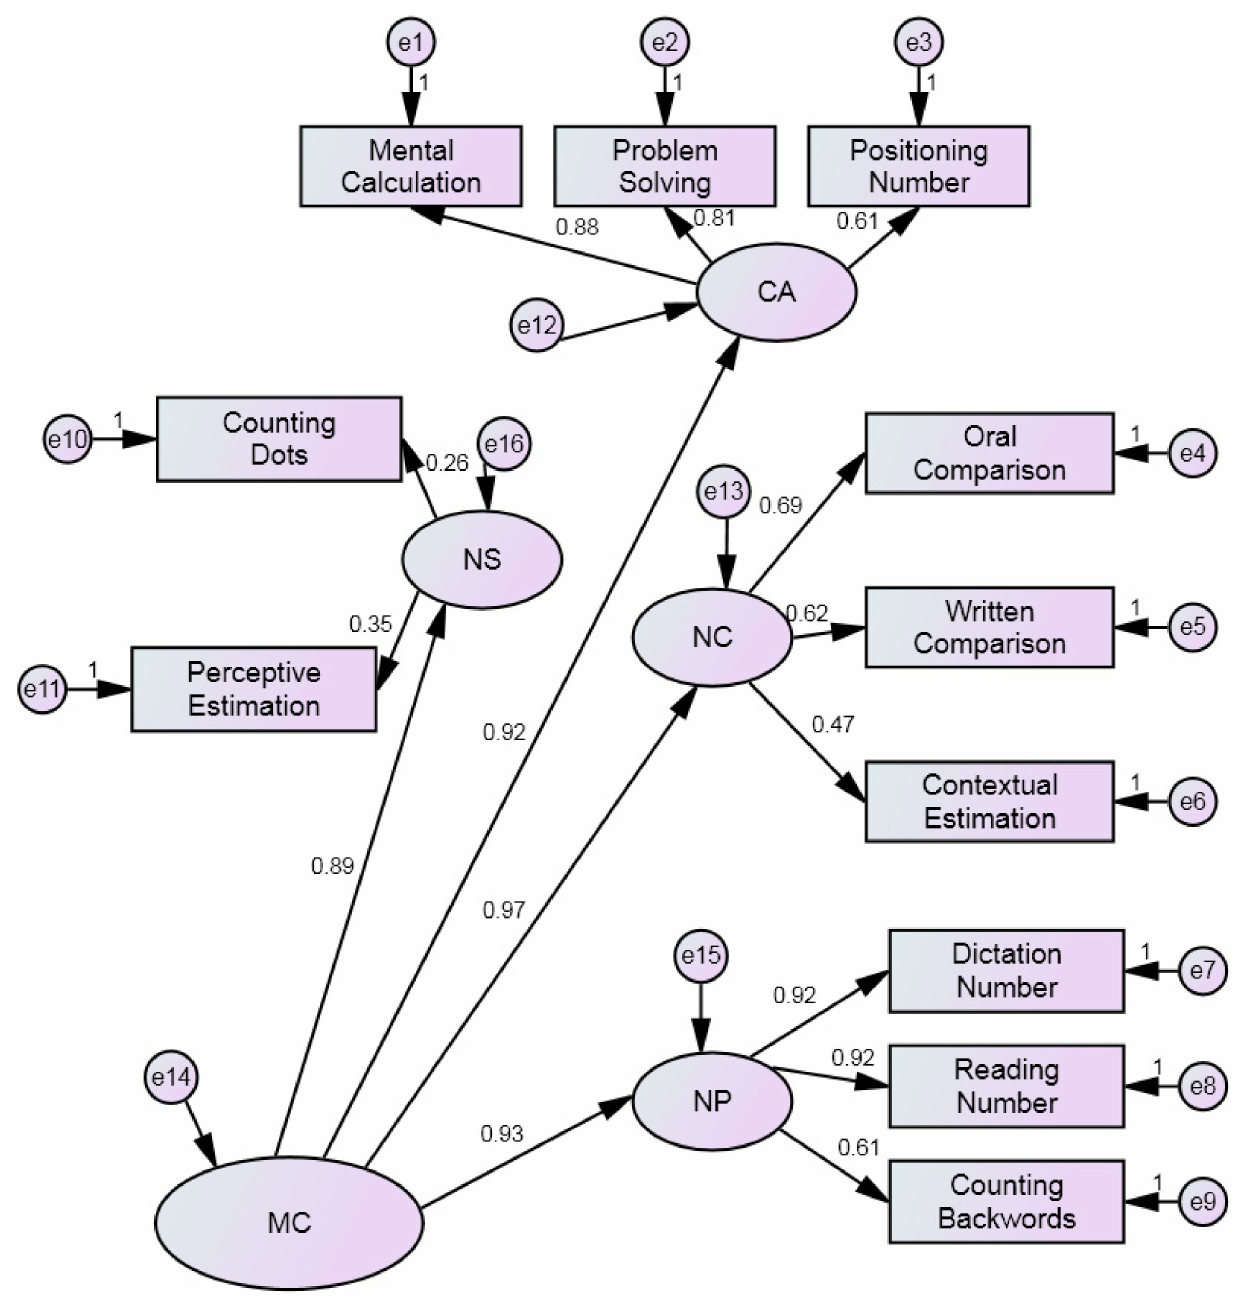
Figure 3. The higher-order mathematical cognition solution (i.e., the four factors plus a mathematics cognition quotient